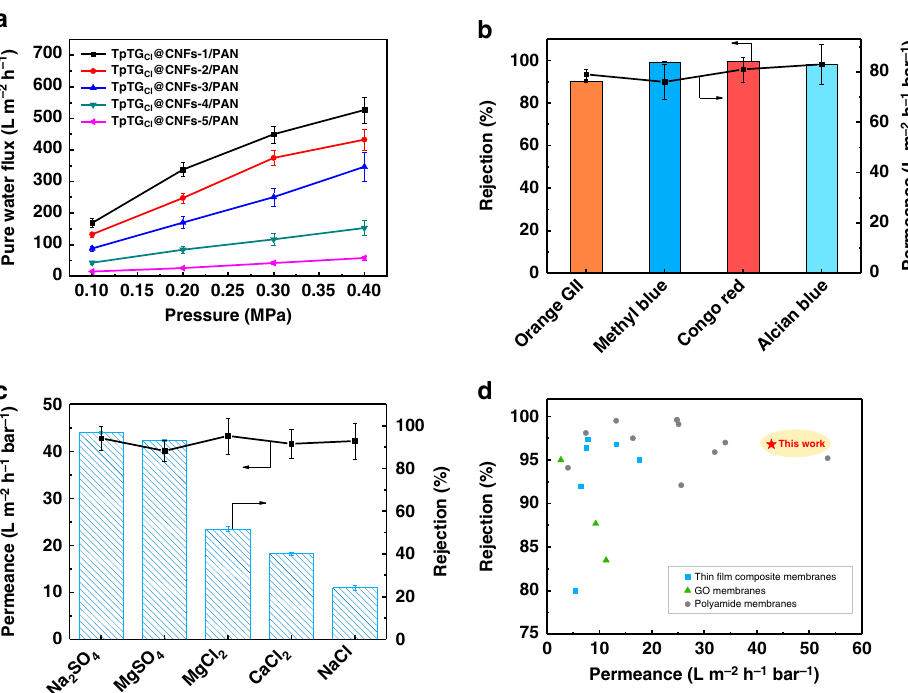
Fig. 5 Dye and salt rejection performance of the membranes. a Pure water fl ux of the TpTG Cl @CNFs-X/PAN membranes as a function of pressure. b Permeance and rejection of the TpTG Cl @CNFs-3/PAN membrane for the nano fi ltration of different dye solutions (dye concentration: 100 ppm; applied pressure: 0.2 MPa). c Permeance and rejection of the TpTG Cl @CNFs-4/PAN membrane for the nano fi ltration of different salt solutions (salt concentration: 1000 ppm; applied pressure: 0.4 MPa). d Comparison of the permeance and rejection of the TpTG Cl @CNFs-4/PAN membrane and the representative membranes in the literatures for rejecting Na 2 SO 4 . Error bars represent standard deviations for 3 SO 4 2 − (0.76 nm), Ca 2 + (0.82 nm) and Mg 2 + (0.86 nm) 47 are all